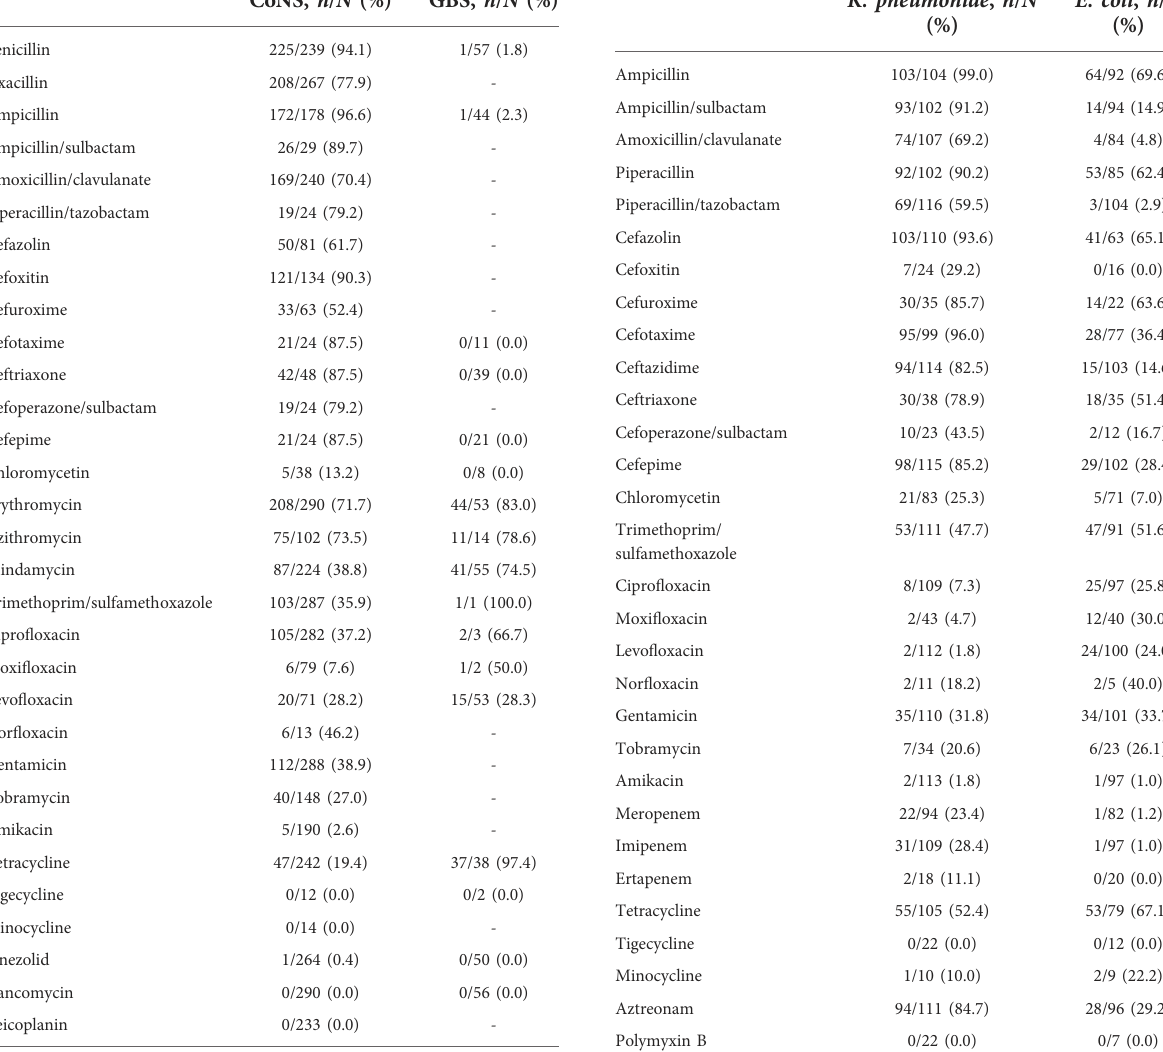
TABLE 2 Antimicrobial resistance in predominant isolates of Gram- TABLE 3 Antimicrobial resistance in predominant isolates of Gram- positive bacterial neonatal sepsis. negative bacterial neonatal CoNS, n / N (%) GBS, n / N (%)